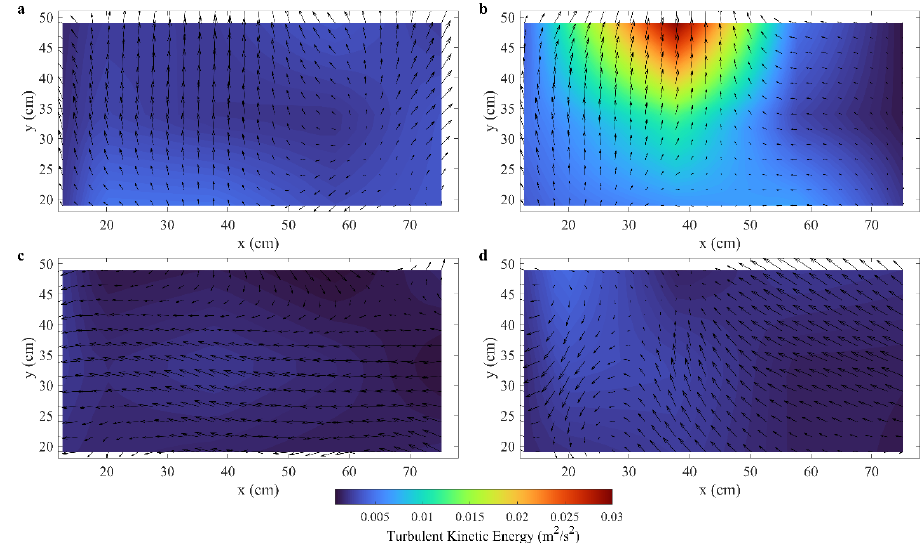
Figure 4. Velocity magnitude contour with velocity vectors measured in front of the ASFL without attraction flow at a depth of ( a ) 30 cm and ( c ) 80 cm and with attraction flow at a depth of ( b ) 30 cm and ( d ) 80 cm. The y – axis origin is the entrance of the ASFL, centered at x = 45 cm. Attraction flow nozzles are located at y = 0, x = 20 and 70 cm. Note, the orientation is the same as Figure 3.